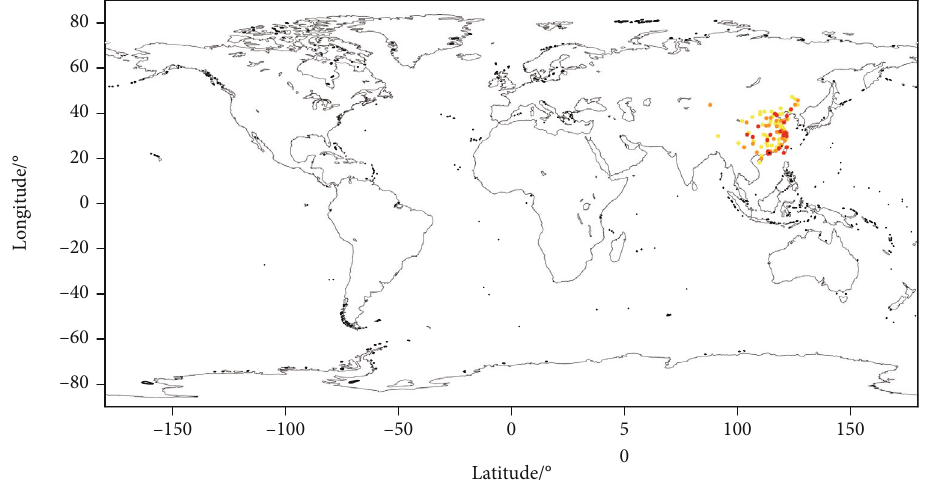
Figure 1: Locations of the 108 key